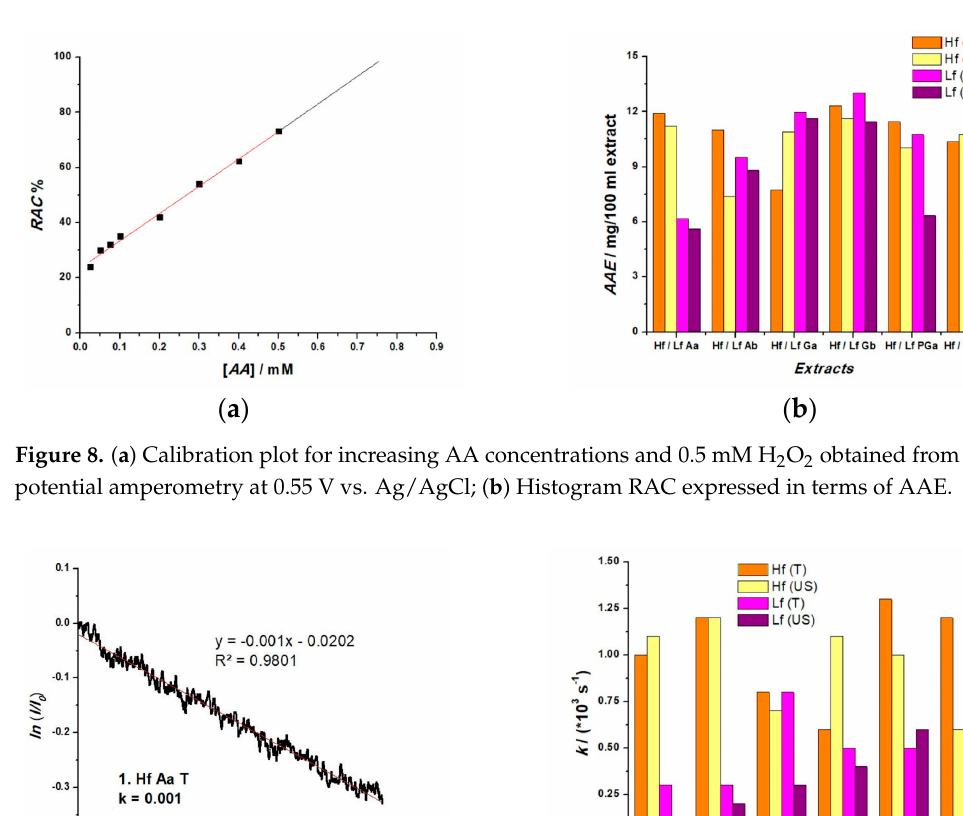
Figure 8. ( a ) Calibration plot for increasing AA concentrations and 0.5 mM H 2 O 2 obtained from fixed potential amperometry at 0.55 V vs. Ag/AgCl; ( b ) Histogram RAC expressed in terms of AAE.